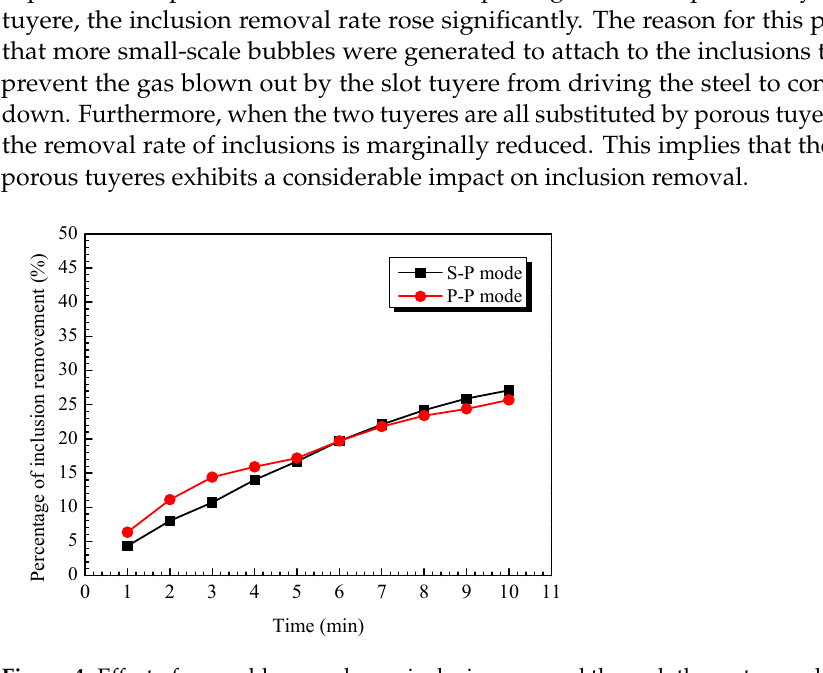
Figure 4. E ff ect of argon-blow modes on inclusion removal through the water model experiment. Figure 4. Effect of argon-blow modes on inclusion removal through the water model